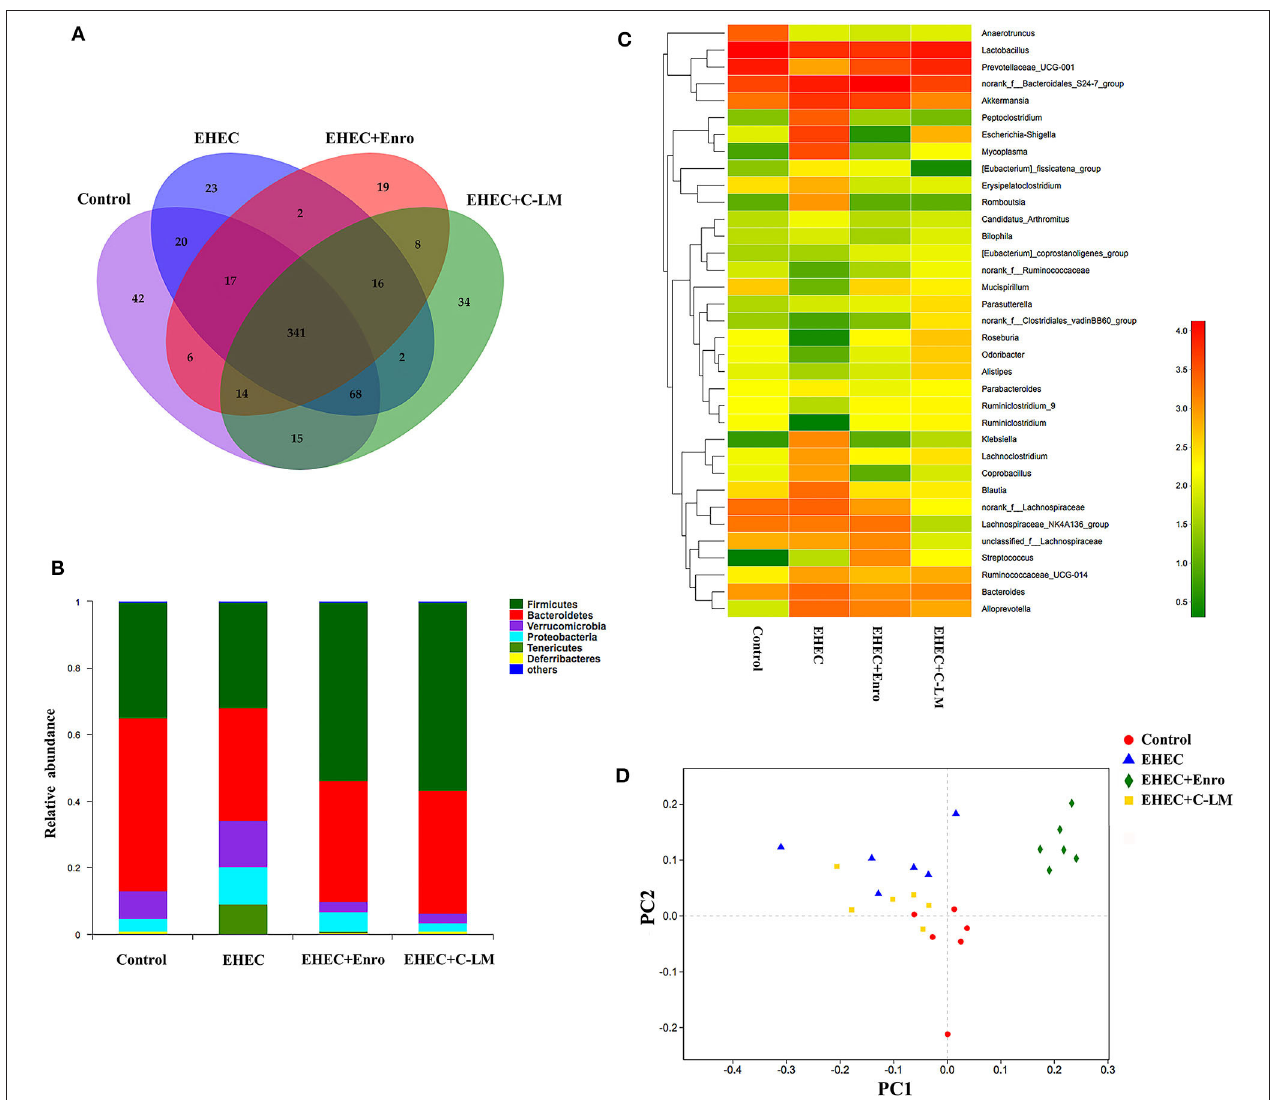
FIGURE 1 | C-L improved the microbiota composition and microbial community balance in mouse intestines. The cecal microbial communities in mice were investigated by 16S rRNA gene sequencing, using the Illumina platform ( n = 6). (A) Venn diagram showing the unique and common OTUs in the mouse intestine. (B) Relative abundance of the most abundant bacterial phyla. (C) Heat map constructed with the top 35 genera. (D) Nonmetric multidimensional scaling based on the OTU levels. The control group was orally administered 100 µ L sterile PBS; the EHEC group was orally administered 100 µ L sterile PBS containing 1 × 10 8 CFUs EHEC O157:H7; the EHEC + Enro and EHEC + C-LM groups were administered 100 µ L sterile PBS containing 1 × 10 8 CFUs EHEC O157:H7 and then treated by i.p. injection with 8 mg/kg Enro and C-L, respectively, once/day for 3